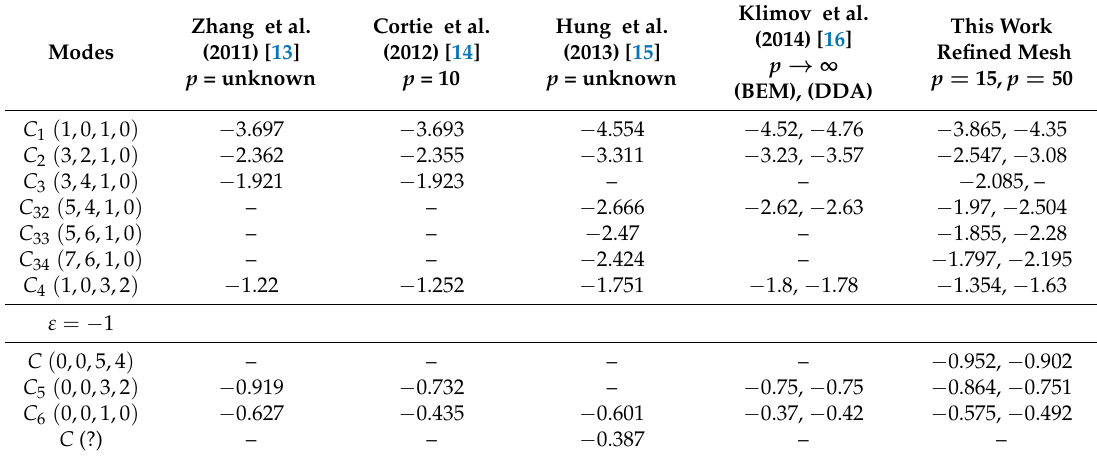
Table 3. Electrostatic resonances of a cube: Recent